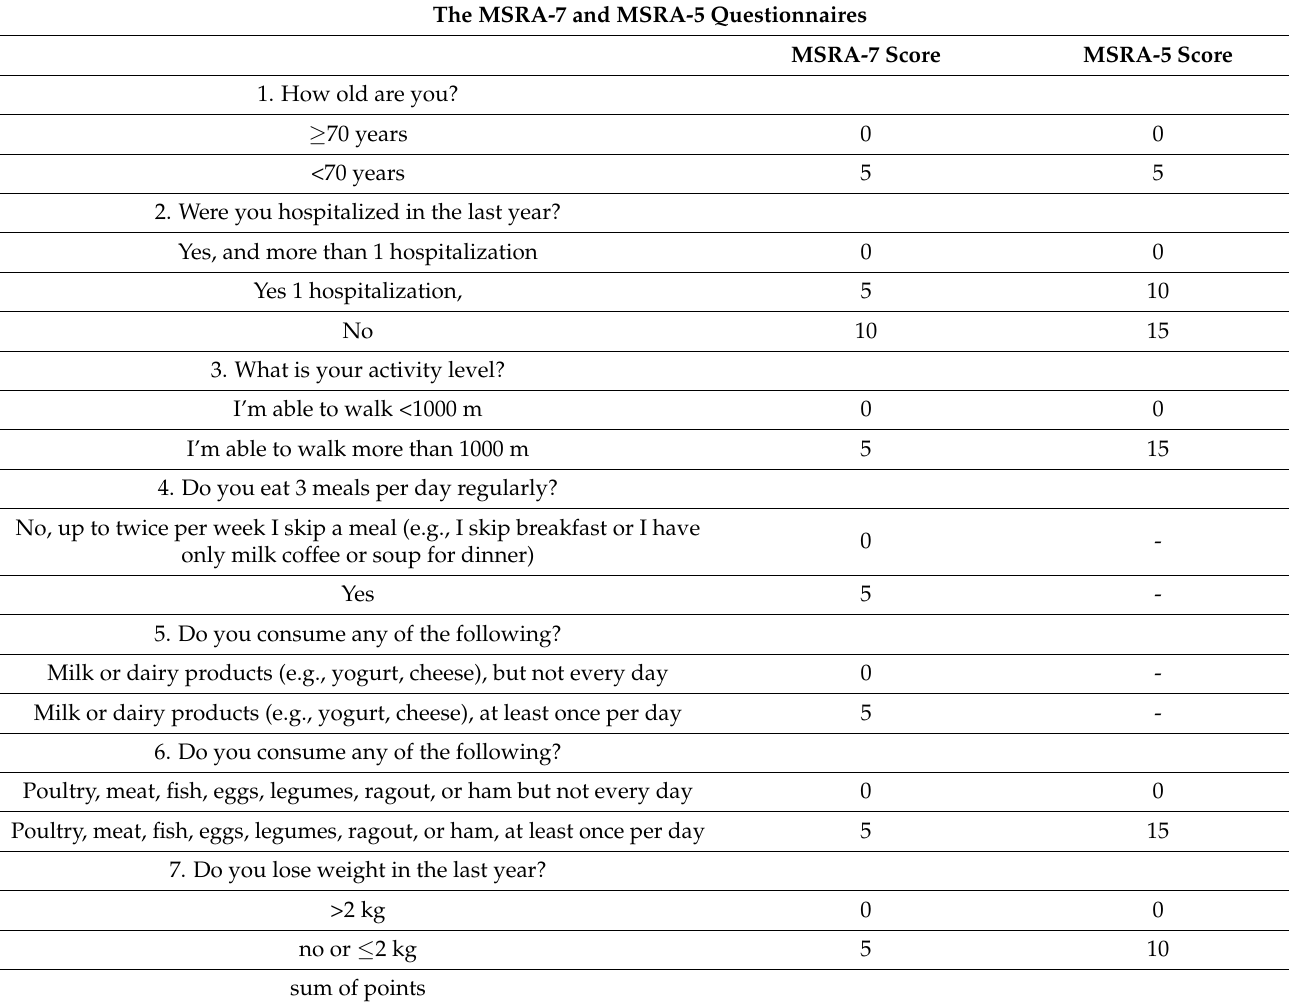
Table 1. The Mini Sarcopenia Risk Assessment (MRSA) 7 and 5 items Questionnaire. The MSRA-7 and MSRA-5